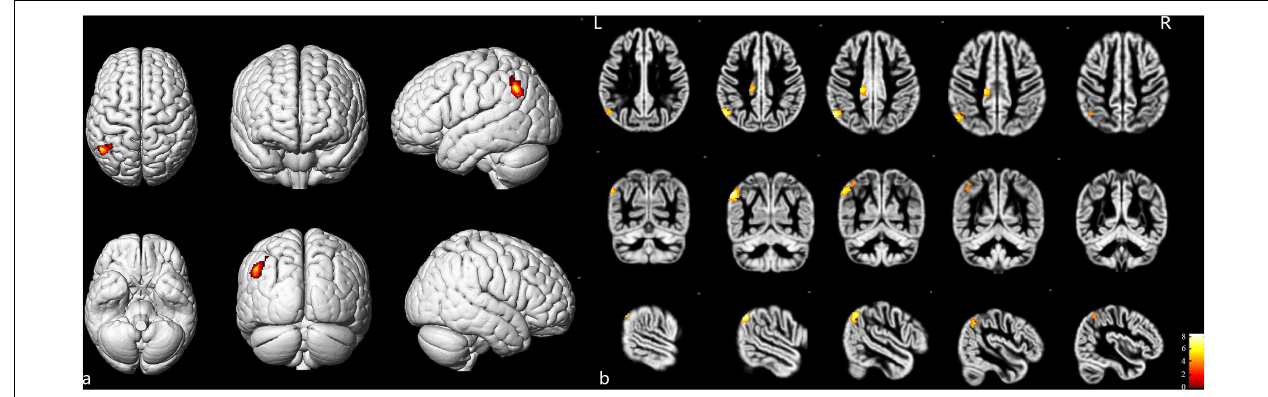
FIGURE 3 | Stenosis-side hemisphere vs. contralateral hemisphere. (a) Three-dimensional image. (b) Slice view. The stenosis-side hemisphere suffered more severe atrophy on inferior parietal lobule and cingulate gyrus, compared with contralateral hemisphere. L: left, R: